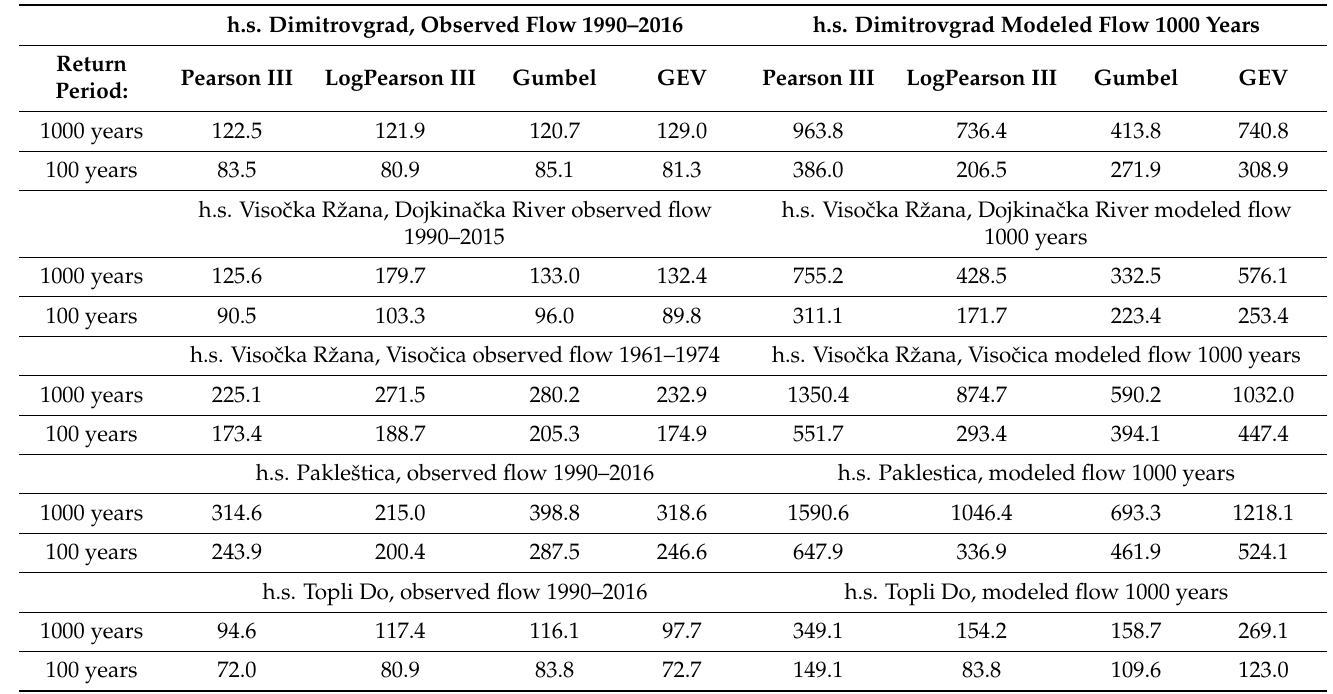
Table 2. Theoretical values of observed and generated extreme flows for hydrological stations